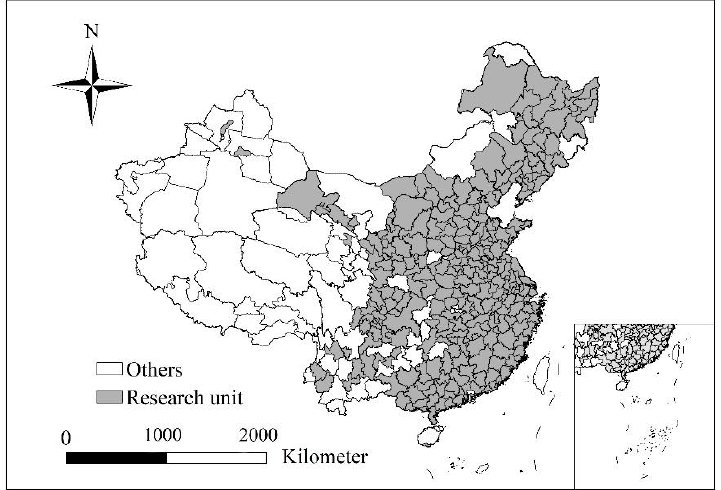
Figure 3. Distribution of cities considered in the research. Note: The investigation only covers built-up areas in these cities.